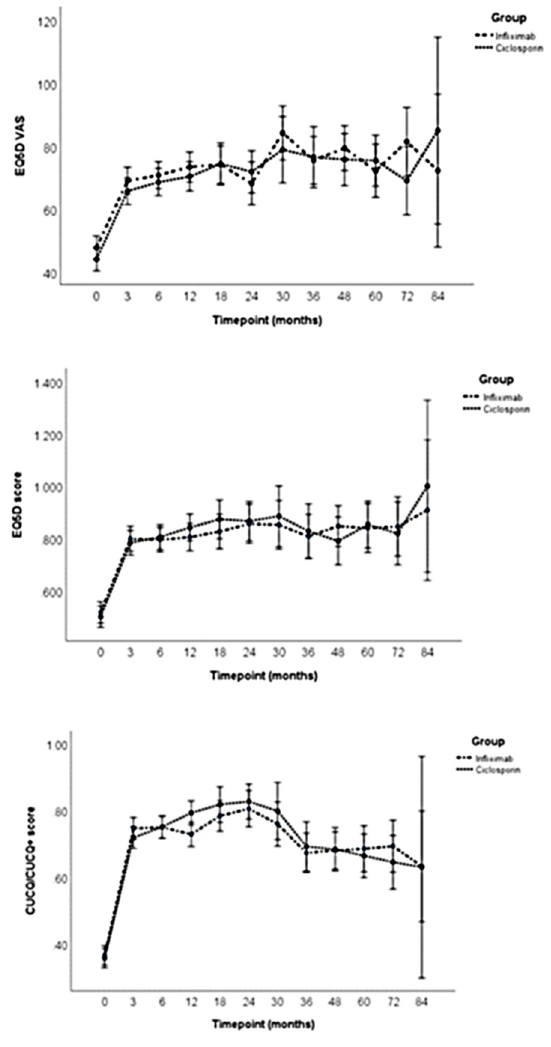
Figure 1. Mean (95% CI) quality of life profiles over time in the infliximab and ciclosporin groups for the EQ5D VAS, EQ5D score and CUCQ/CUCQ+.